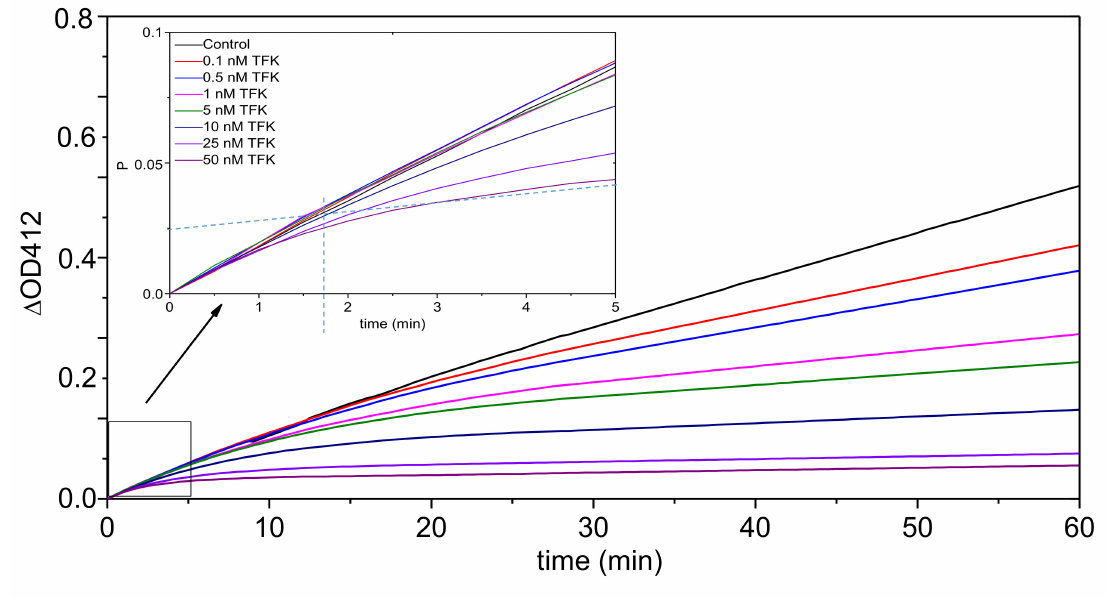
Figure 2. Typical progress curves (without treatment for smoothing noise) for slow-binding inhibition of AChE by TFK. [E] = 0.08 nM, [ATC] = 0.1 mM and [TFK] ranged from 0.1 to 50 nM. ∆ OD 412 is the concentration of ATC hydrolysis product (in Equation (1), [P] = thiocholine = thionitrobenzoate), expressed as the absorbance increase at 412 nm. The reciprocal of k obs is the lag time (vertical dotted line at t = 1.75 min for 50 nM TFK) before steady state. Progress curves fit to Equation (1). Initial fast inhibition type and inhibition constant ( K i = k − 3 / k + 3 ) for the first binding step (formation of EI) were determined from tangents to progress curves k obs vs. time (Figure 2), Dixon and Cornish-Bowden plots (Figure 3). Three di ff erent concentrations of ATC were used (0.1; 0.5 and 1 mM). Panels A and B in Figure 3 provide evidence that fast reversible inhibition step is competitive (Dixon plots are intersecting at-[TFK] = K ci and Cornish-Bowden plots are parallel) with K ci = K i = 5.15 ± 0.36 nM.